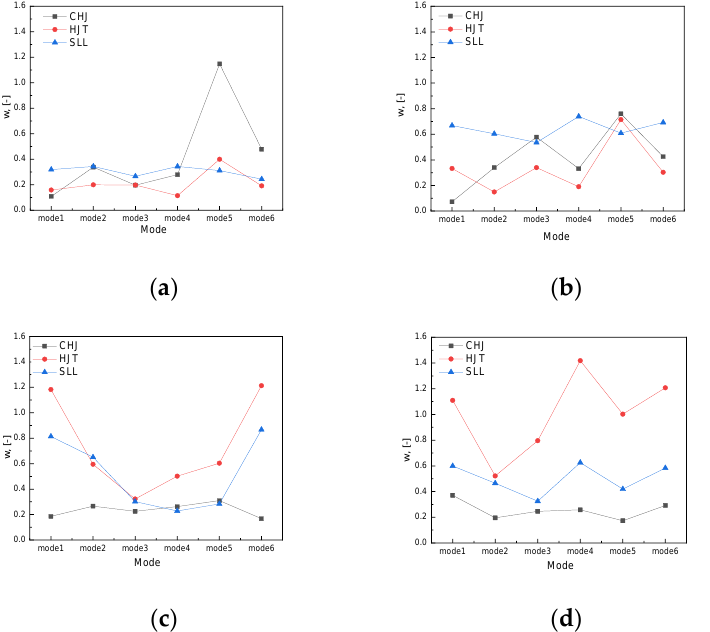
Figure 12. Filling coefficient of different laying modes. (( a ) 0.8 m/min, with solidification; ( b ) 2.4 m/min, with solidification; ( c ) 0.8 m/min, without solidification; ( d ) 2.4 m/min, without solidification).